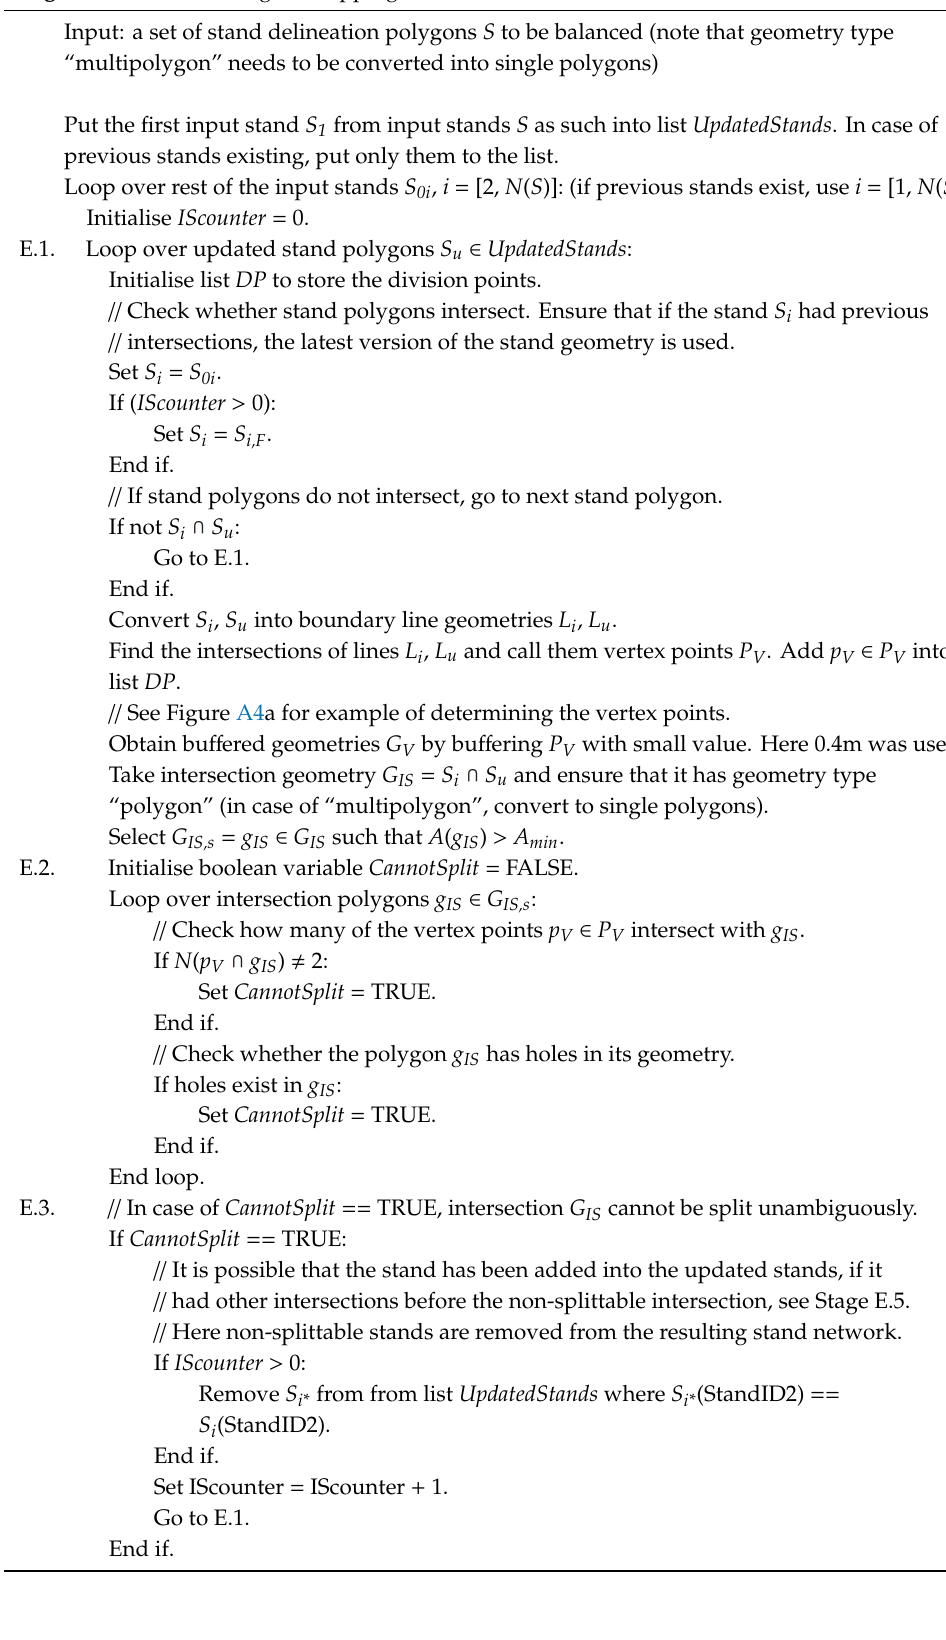
Algorithm A3 : Balancing overlapping stand